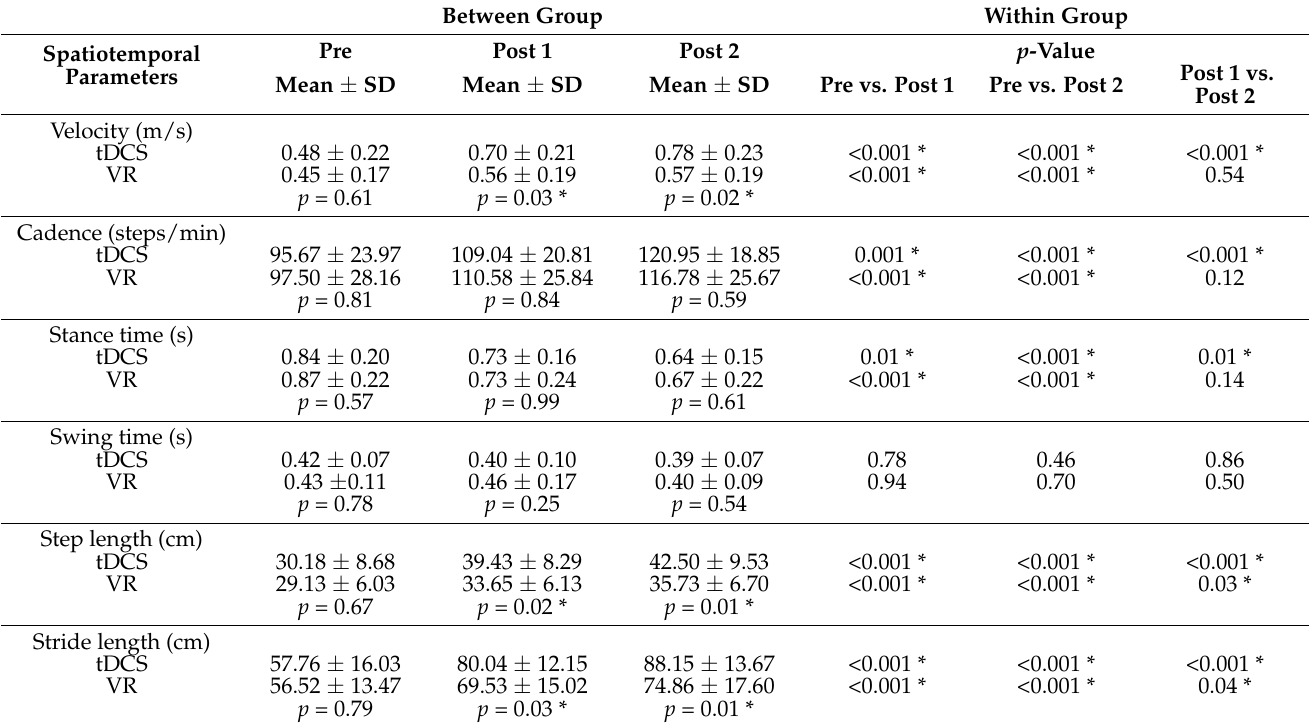
Table 3. Between-group and within-group comparisons of spatiotemporal parameters at Pre, Post 1, and Post